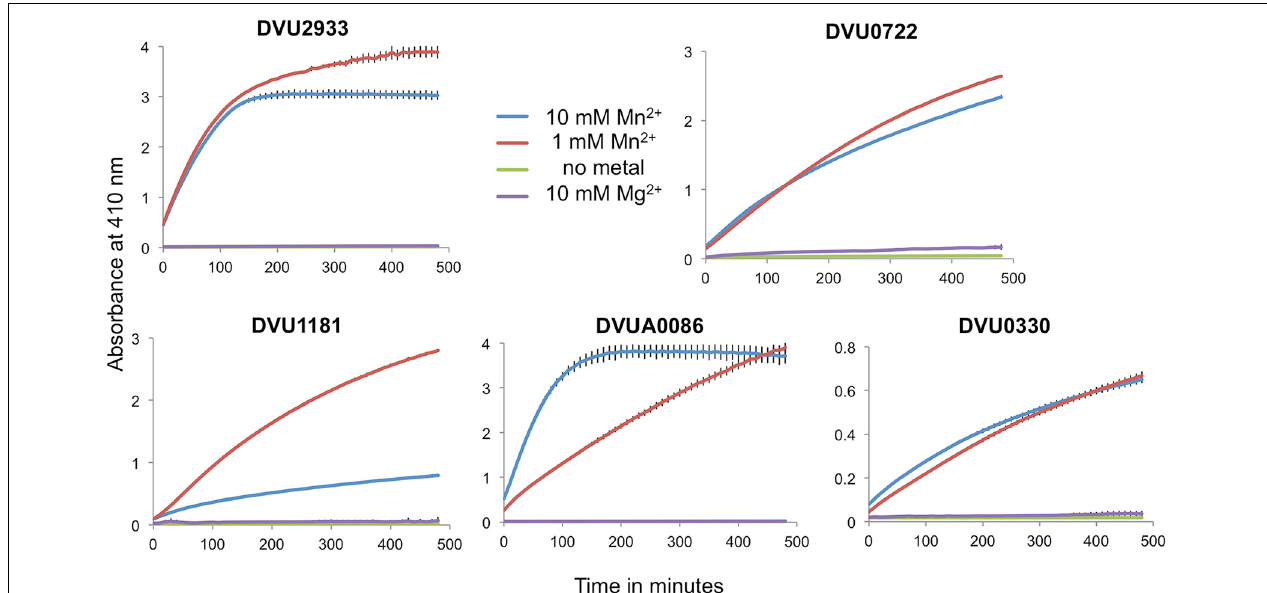
metal,andtheproductwasmeasuredspectrophotometricallyatanabsorbance of 410nm. Data are shown for the mean of triplicate reactions, with error bars indicating standard deviation. Note the differences in the scales on the y-axes.